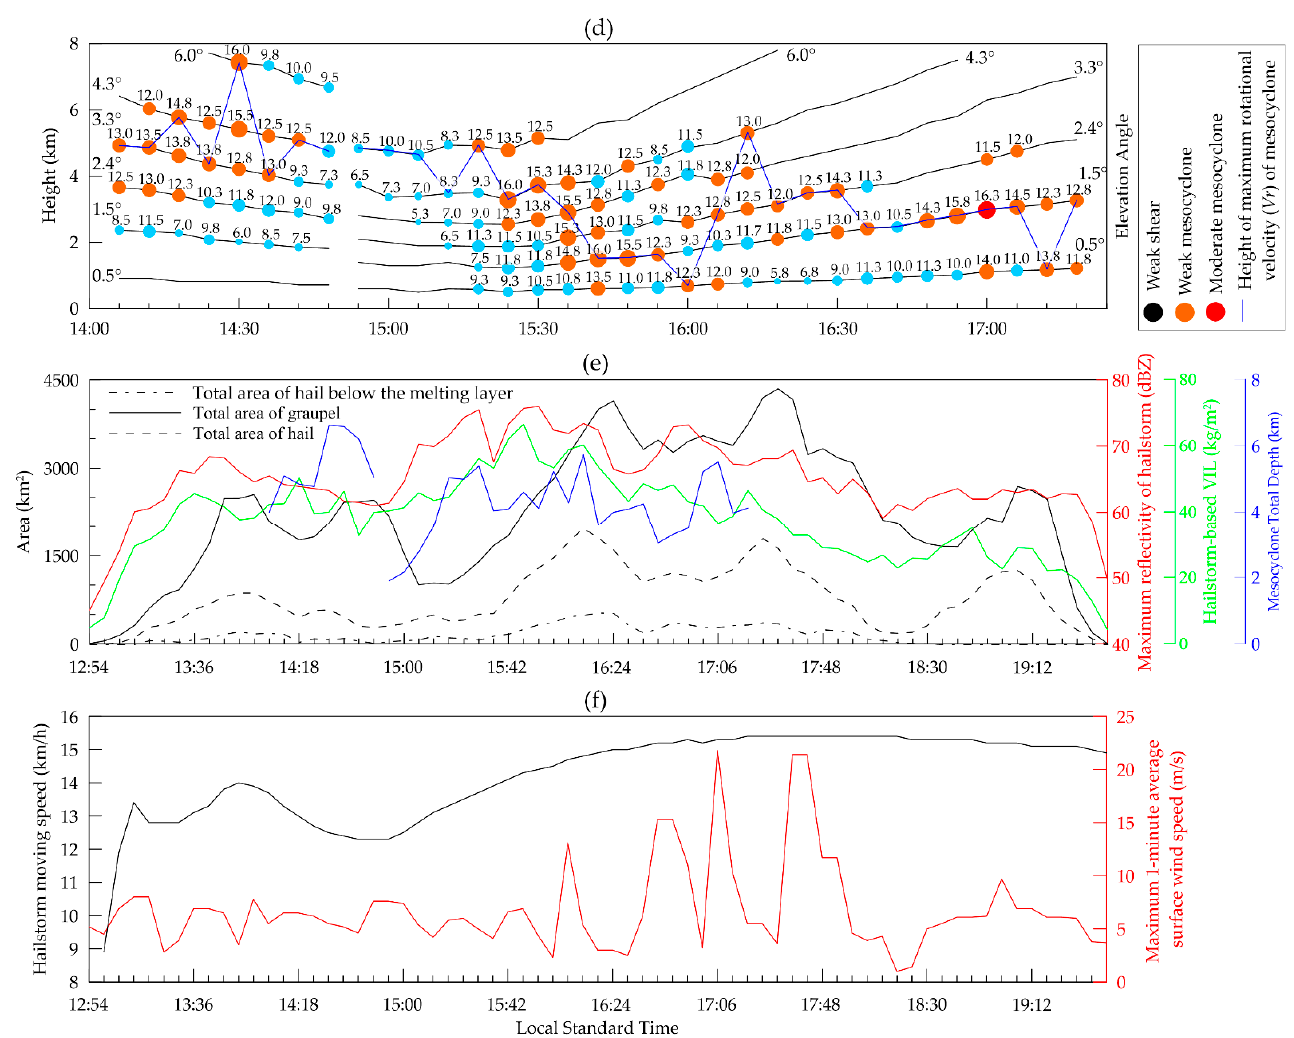
Figure 9. Temporal evolution of ( a ) the maximum reflectivity (denoted by pixels) of the hailstorm at each height layer; ( b ) the graupel area (denoted by pixels) at each height layer; ( c ) the hail area (denoted by pixels) at each height layer; ( d ) the maximum rotational velocity (denoted by pixels and values) of long-lived Mesocyclones 1 and 4 at each shear layer; ( e ) several new storm characteristics output from the ICCE algorithm, including the hailstorm’s maximum reflectivity, the hailstorm-based VIL, the total area of hail or graupel, the total area of hail below the melting layer, and the mesocyclone total depth; and ( f ) the maximum 1-min average wind speed near the hailstorm trajectory collected by automatic meteorological observation stations and the hailstorm moving speed obtained by the modified SCIT algorithm from 1254 to 1948 LST on 11 April 2019.